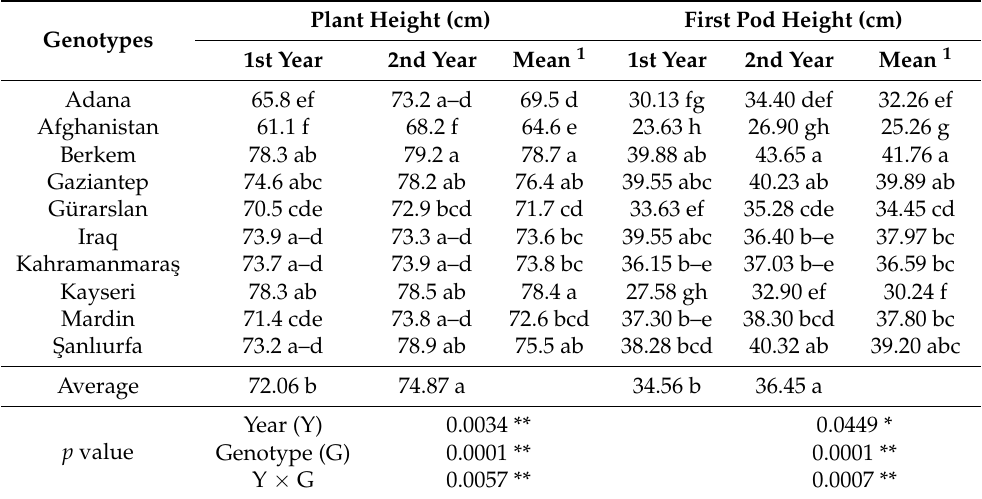
Table 3. Average values for the plant heights and first pod heights of fenugreek genotypes.